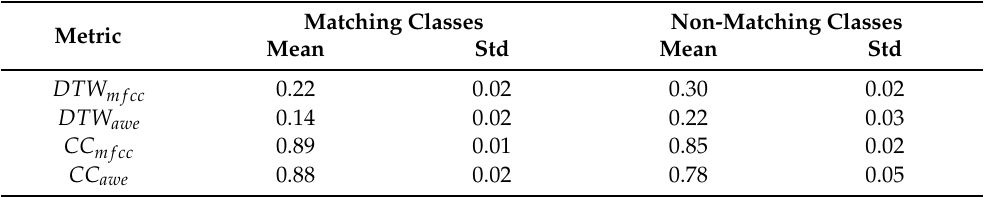
Table 2. Average DTW-distance and maximum of cross-correlation between samples in the reference